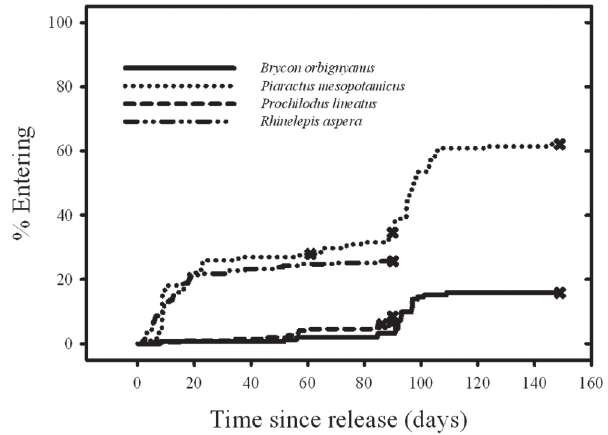
Fig. 4. Entry rates for fish released downstream that found the fish ladder entrance during study